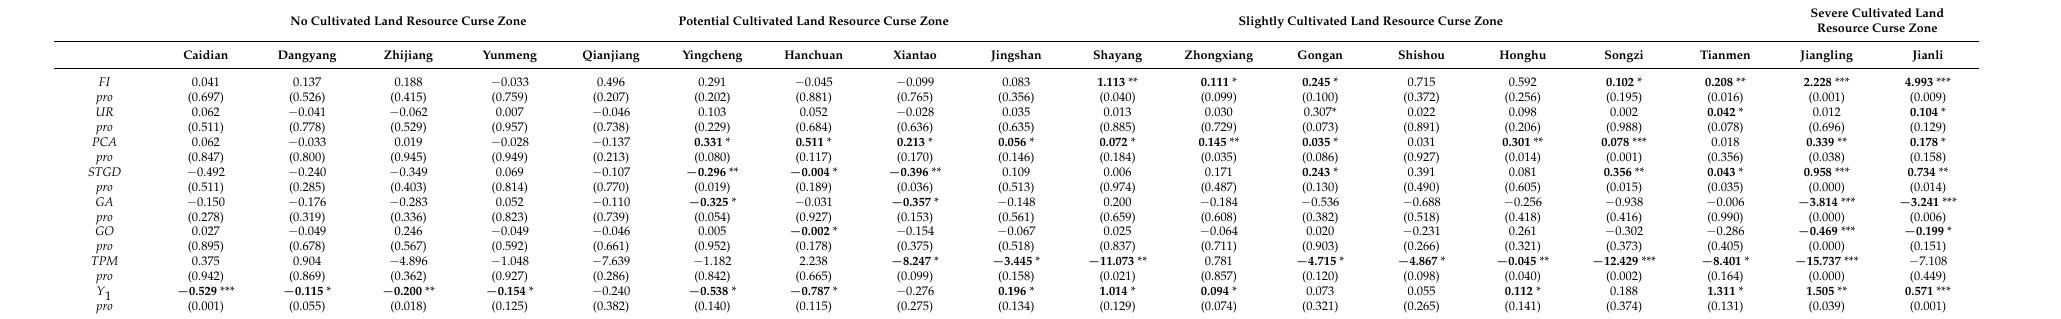
Table 3. Results of the panel data model of the cultivated land resource curse in Jianghan